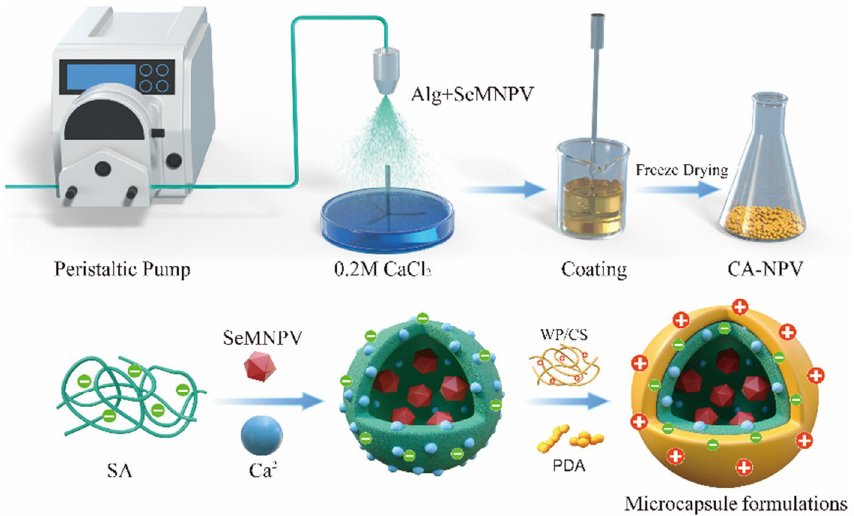
Figure 1. Preparation process of four microcapsule formulations. Solutions of Chitosan and of Whey Protein were prepared. The PDA solution was prepared by adding of dopamine hydrochloride to Tris–HCl buffer, and incubating for 12 h at room temperature. The same quanlity CA-NPV gel was added into the above three solutions, stirred for 40 min, then centrifugally washed thrice. The dried CS@CA-NPV, WP@CA-NPV,